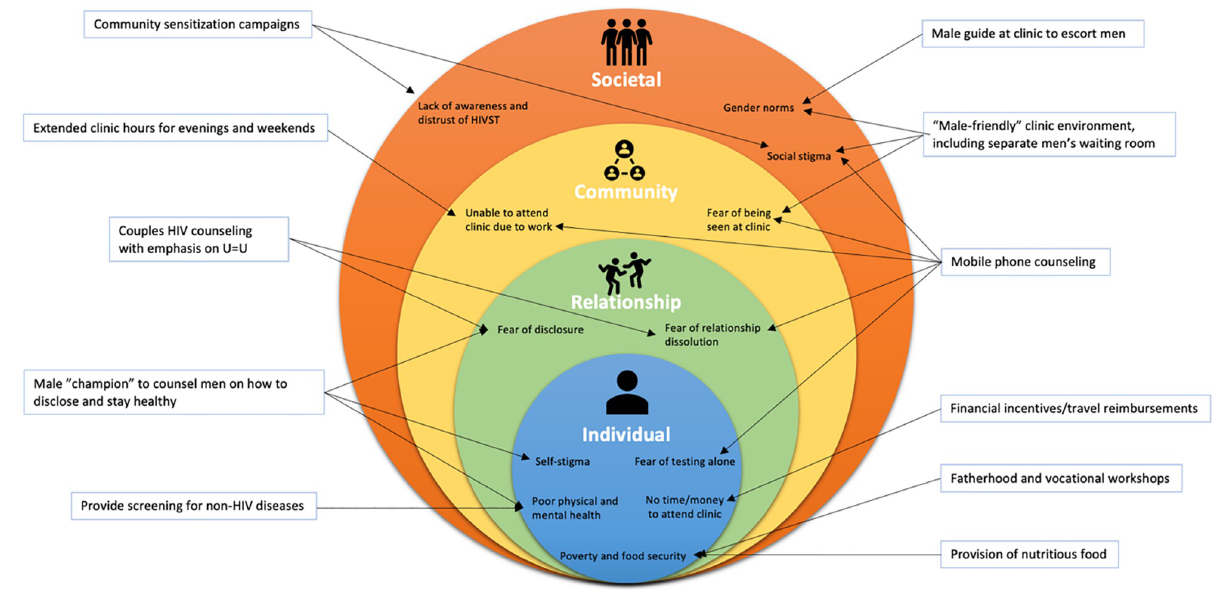
Fig 2. Socio-ecological model with barriers and facilitators. Fig 2 summarizes the key themes discussed by participants, based on a socio-ecological model. Within each ring of the framework, common barriers for uptake of secondary distribution of HIVST are presented. Outside of the rings, common facilitators that could support or motivate uptake are presented; arrows point to barriers that the facilitators might be relevant for addressing.